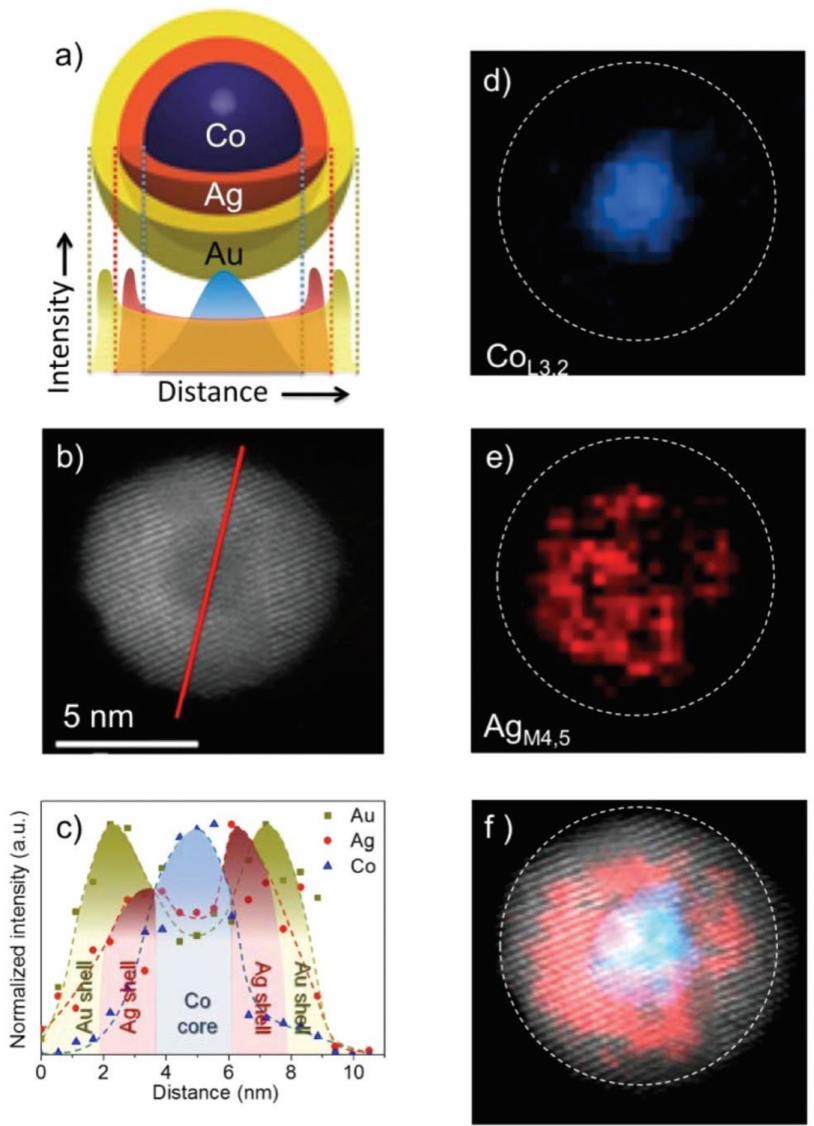
Figure 5. ( a ) Representation of the Co@Ag@Au structure together with the expected EDX intensity profiles. ( b ) TEM representative image of a Co@Ag@Au nanoparticle. ( c ) EDX line scan performed at the Co, Ag and Au peaks along the line depicted in ( b ). ( d ) EELS compositional analysis for the Co L 3,2 edge. The dashed line represents the outer limit of the nanoparticle. ( e ) EELS map for the Ag M 4,5 edge. ( f ) STEM image together with the corresponding Co and Ag EELS concentration maps superimposed. Reproduced with permission from